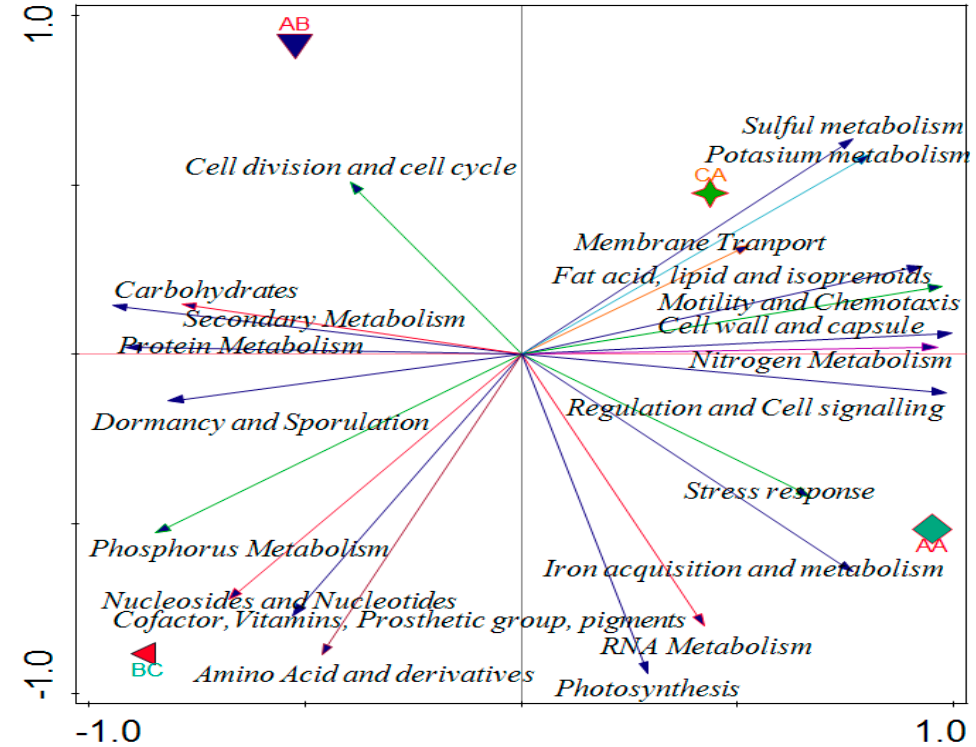
Figure 4. PCA analysis of functional categories of microbial communities in the rhizosphere and bulk soil samples showing the distribution of the microbial functions. AA, AB, and CA are rhizo- sphere soil samples while BC is a bulk soil sample.